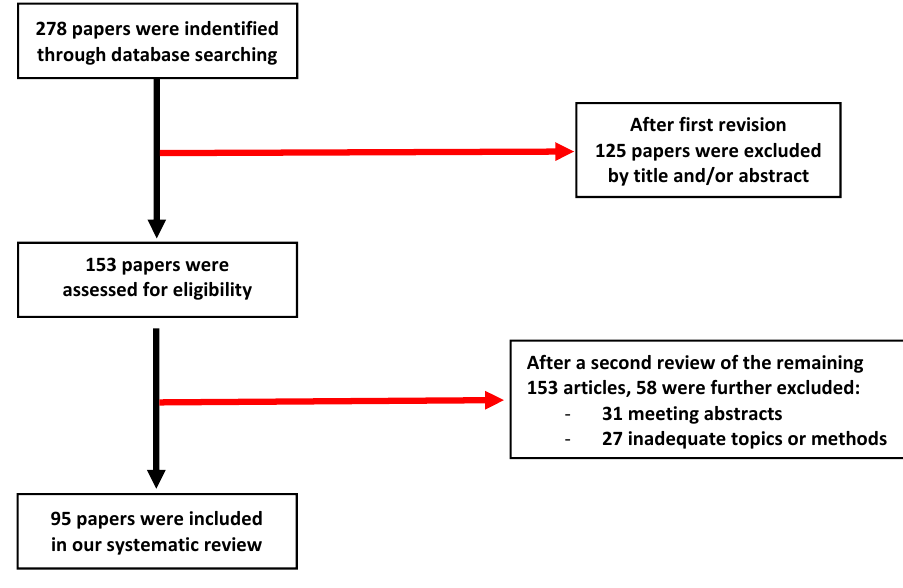
Figure 1. Flowchart.